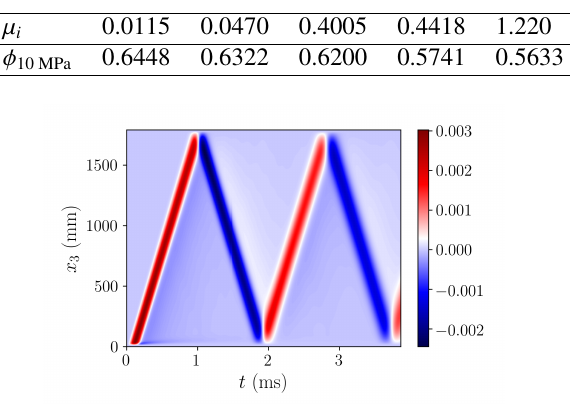
Table 1: Initial interparticle friction coe ffi cient versus solid volume fractions at a confining pressure of 10 MPa